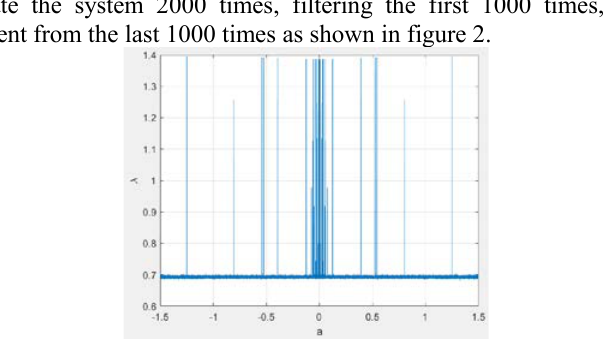
Fig. 2. Lyapunov exponent spectrum.